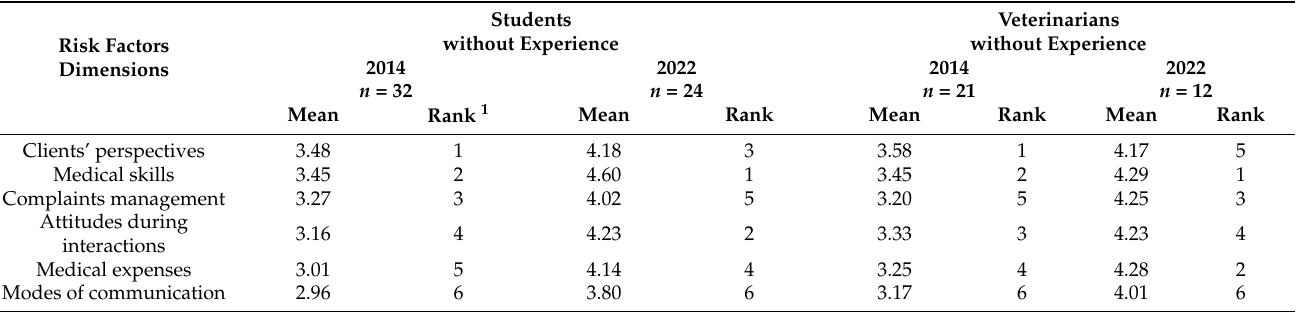
Table 4. Ranking of the perceptions of risk factors in six dimensions for inexperienced Veterinarians and students in 2014 and 2022.